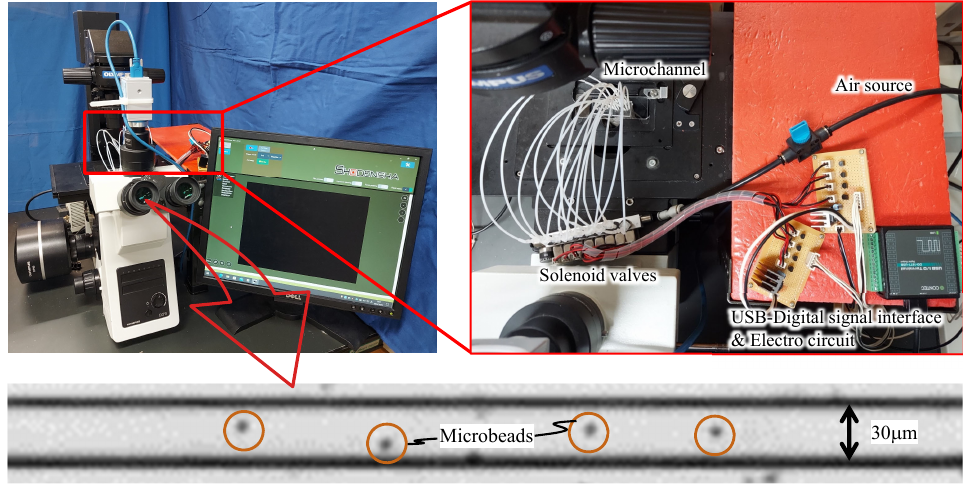
Figure 5. Experimental setup: overall experimental system and view from the microscope.